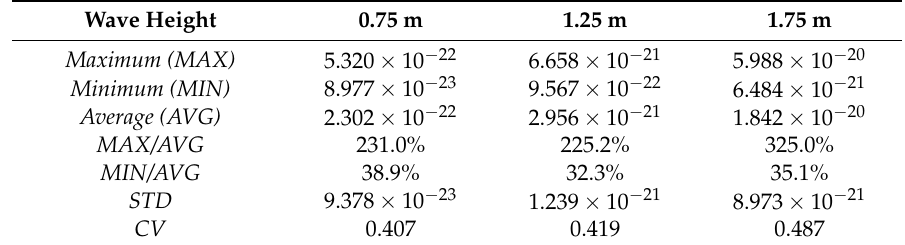
Table 2. Extreme and average values, CV, and deviation of the fatigue damage for the wave-load-alone cases.